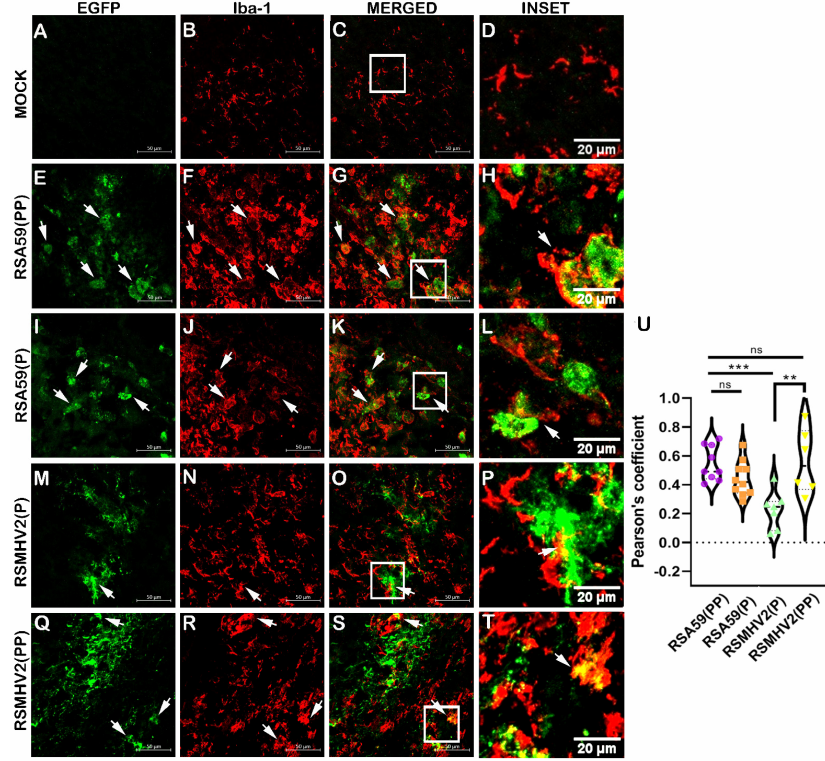
Figure 4. Colocalization study of two proline containing strains RSA59(PP), RSMHV2(PP) and single proline containing strains RSMHV2(P), RSA59(P) infected cells with microglia in the brain of mice at day 5 p.i. Cryosections of the brain of infected mice and mock-infected mice were immunofluores- cently labeled with Iba-1 ( B , F , J , N , R ). EGFP marks the infected cells in panels ( E , I , M , Q ), and mock in panel ( A ). Green and red channels are merged ( C , G , K , O , S ) and show colocalization of EGFP with Iba-l-positive cells with arrowheads highlighting virus infected microglia. Mock infected sections are shown in panels ( A – D ), RSA59(PP) infected sections in panels ( E – H ), RSA59(P) infected sections in panels ( I – L ), RSMHV2(P) infected sections in panels ( M – P ), and RSMHV2(PP) infected sections in panels ( Q – T ). The insets marked by a white rectangle in the merged panels show a magnified view of the colocalization of microglia with EGFP (seen as yellow) in panels ( D , H , L , P , T ). Quantification of infected microglia as the Pearson coefficient was done and plotted in a violin diagram ( U ). The One-way ANOVA was used to compare RSA59(PP) with RSA59(P), RSMHV2(P), RSMHV2(PP), and RSMHV2(P) with RSMHV2(PP). The level of significance was taken at. ** p < 0.001, *** p < 0.0001, and ns denotes